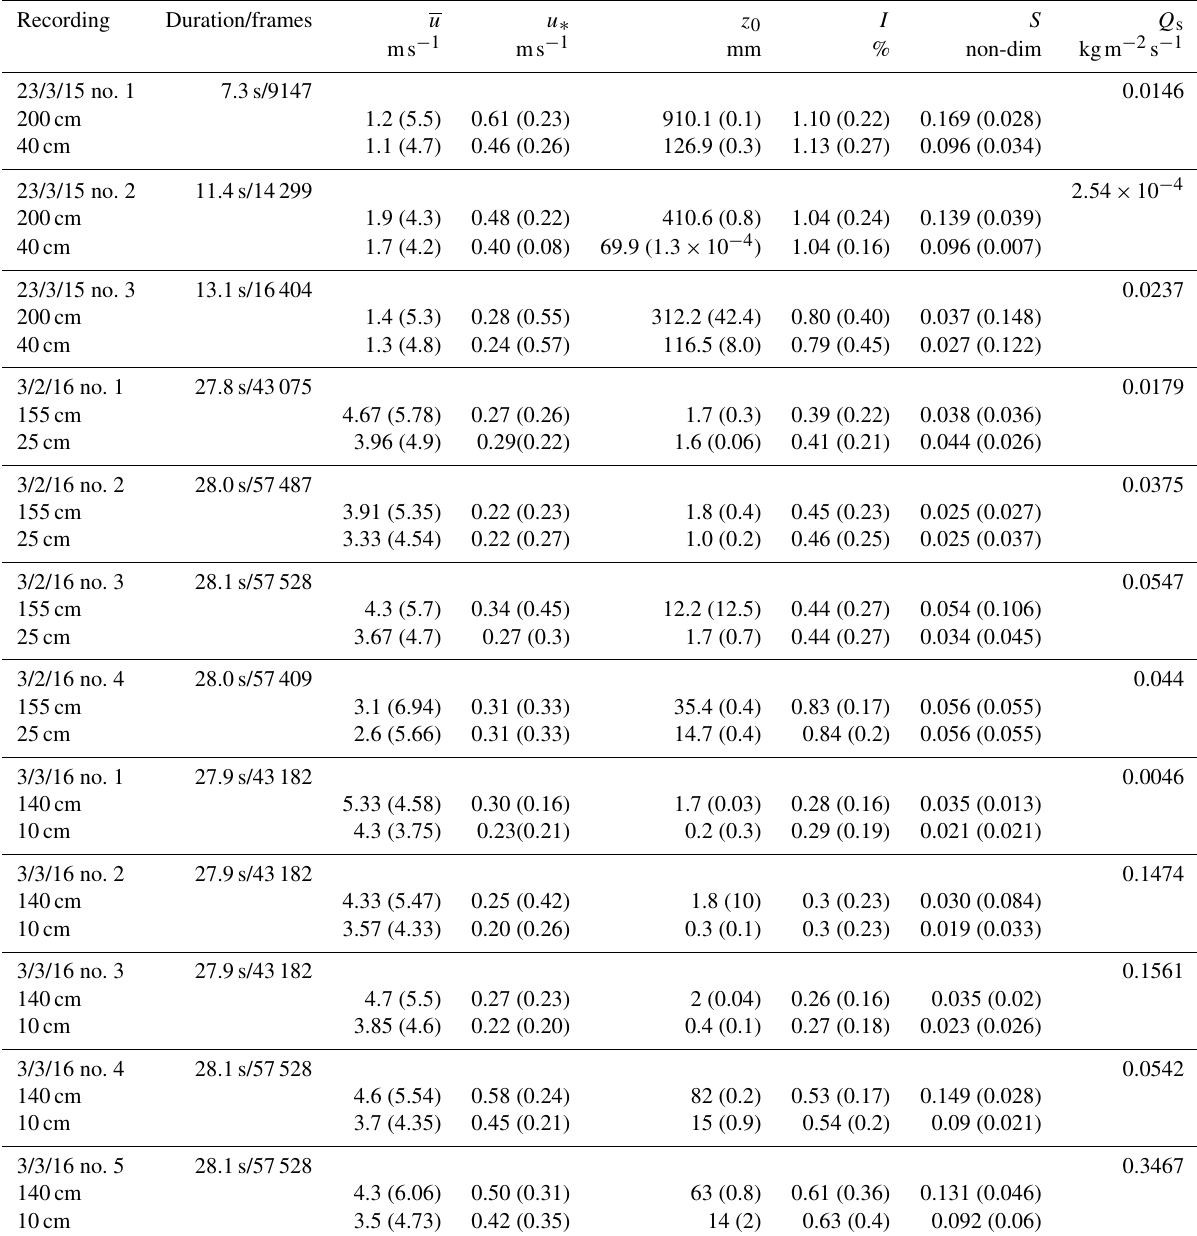
Table 2. Wind characteristics: mean wind speed u , friction velocity u ∗ , aerodynamic roughness height z 0 , turbulence intensity I , and Shields parameter S for recordings on 23 March 2015, 3 February, and 3 March 2016. Average values from the 15min surrounding each recording (and recording-only period in parentheses) are shown for the two measurement heights. Estimates of blowing snow flux Q s in kgm − 2 s − 1 are included for recording only